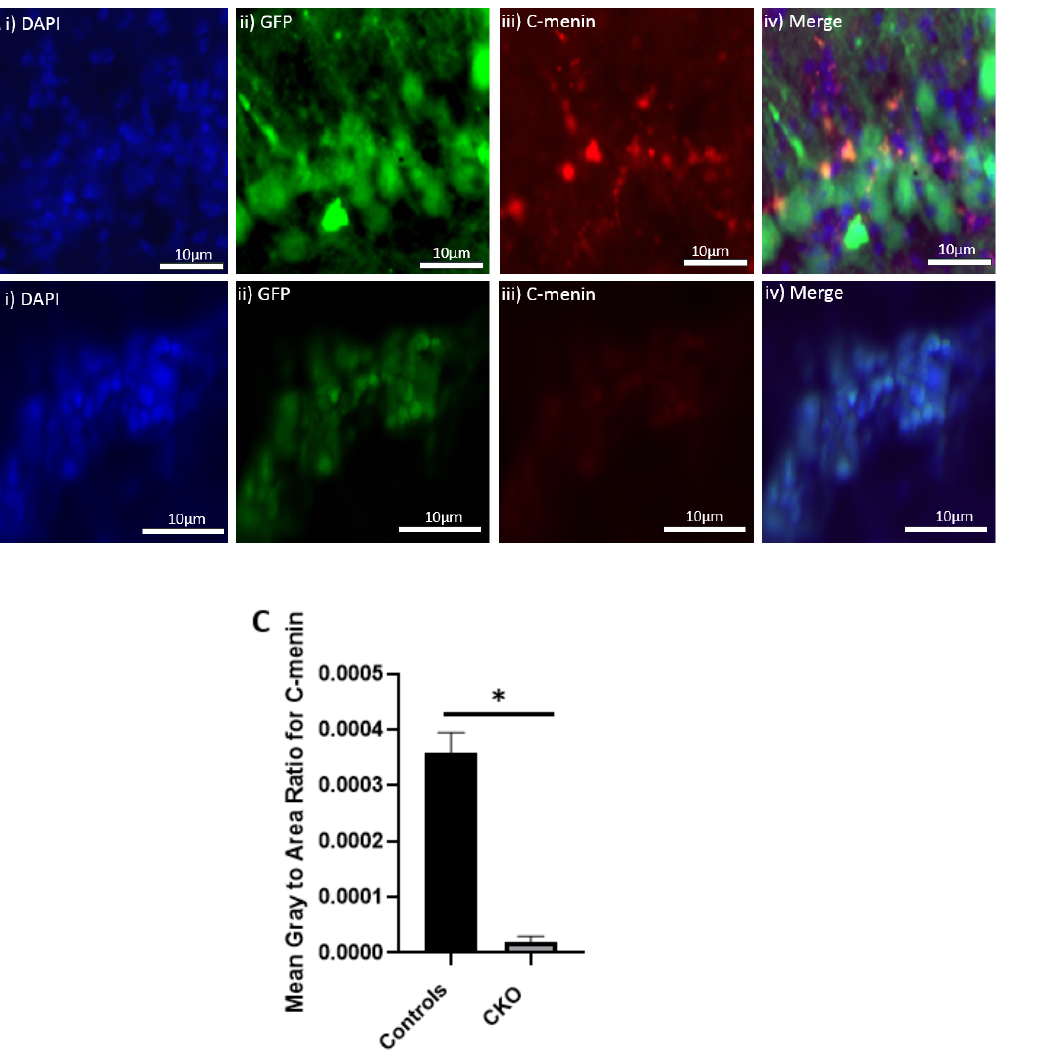
Figure 7. Reduced menin expression in the hippocampal sections of the CKO animals. ( A ) Hippocampal section of the control mice injected with the control virus; ( i ) DAPI for nuclear staining; ( ii ) GFP-expressing neurons after the transduction of the control virus ( iii ). C-menin’s expression in the neurons ( iv ). Merge for showing the overlap between GFP-expressing neurons, DAPI, and C-menin; ( B ) hippocampal section of the CKO mice injected with the Cre-expressing virus; ( i ) DAPI for nuclear staining; ( ii ) GFP-expressing neurons after the transduction of the Cre recombinase-inducing virus; ( iii ) C-menin’s weak signal in the neurons; ( iv ) merge for showing the overlap between GFP expression, DAPI, and C-menin; ( C ) summary data, showing the reduction in menin’s signal as measured by mean gray-to-area ratio in the CKO compared to the controls. Data represent the mean ratio ± SEM. n = 4. Statistical significance (Mann–Whitney U test), * p <